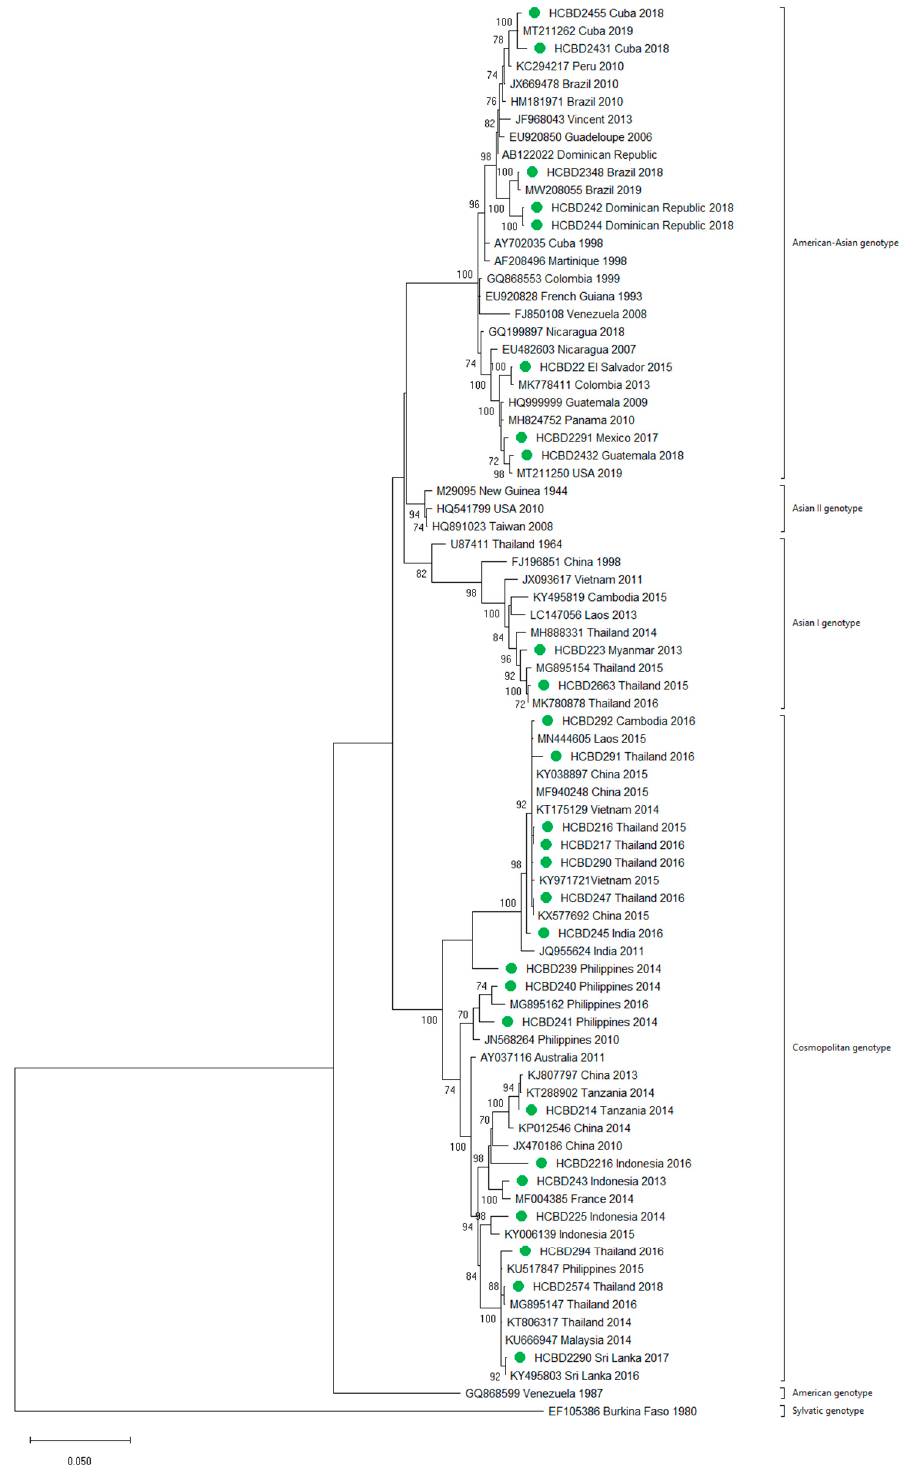
Figure 4. Phylogenetic tree of DENV-2 strains based on the E gene. Strains are denoted by the GenBank accession number, place and year of isolation. The green dots indicate the strains sequenced in this study and the scale bar indicates substitutions per site. The analysis was performed using the maximum likelihood method (TN93 + G + I) with a bootstrap of 1000 replicates.